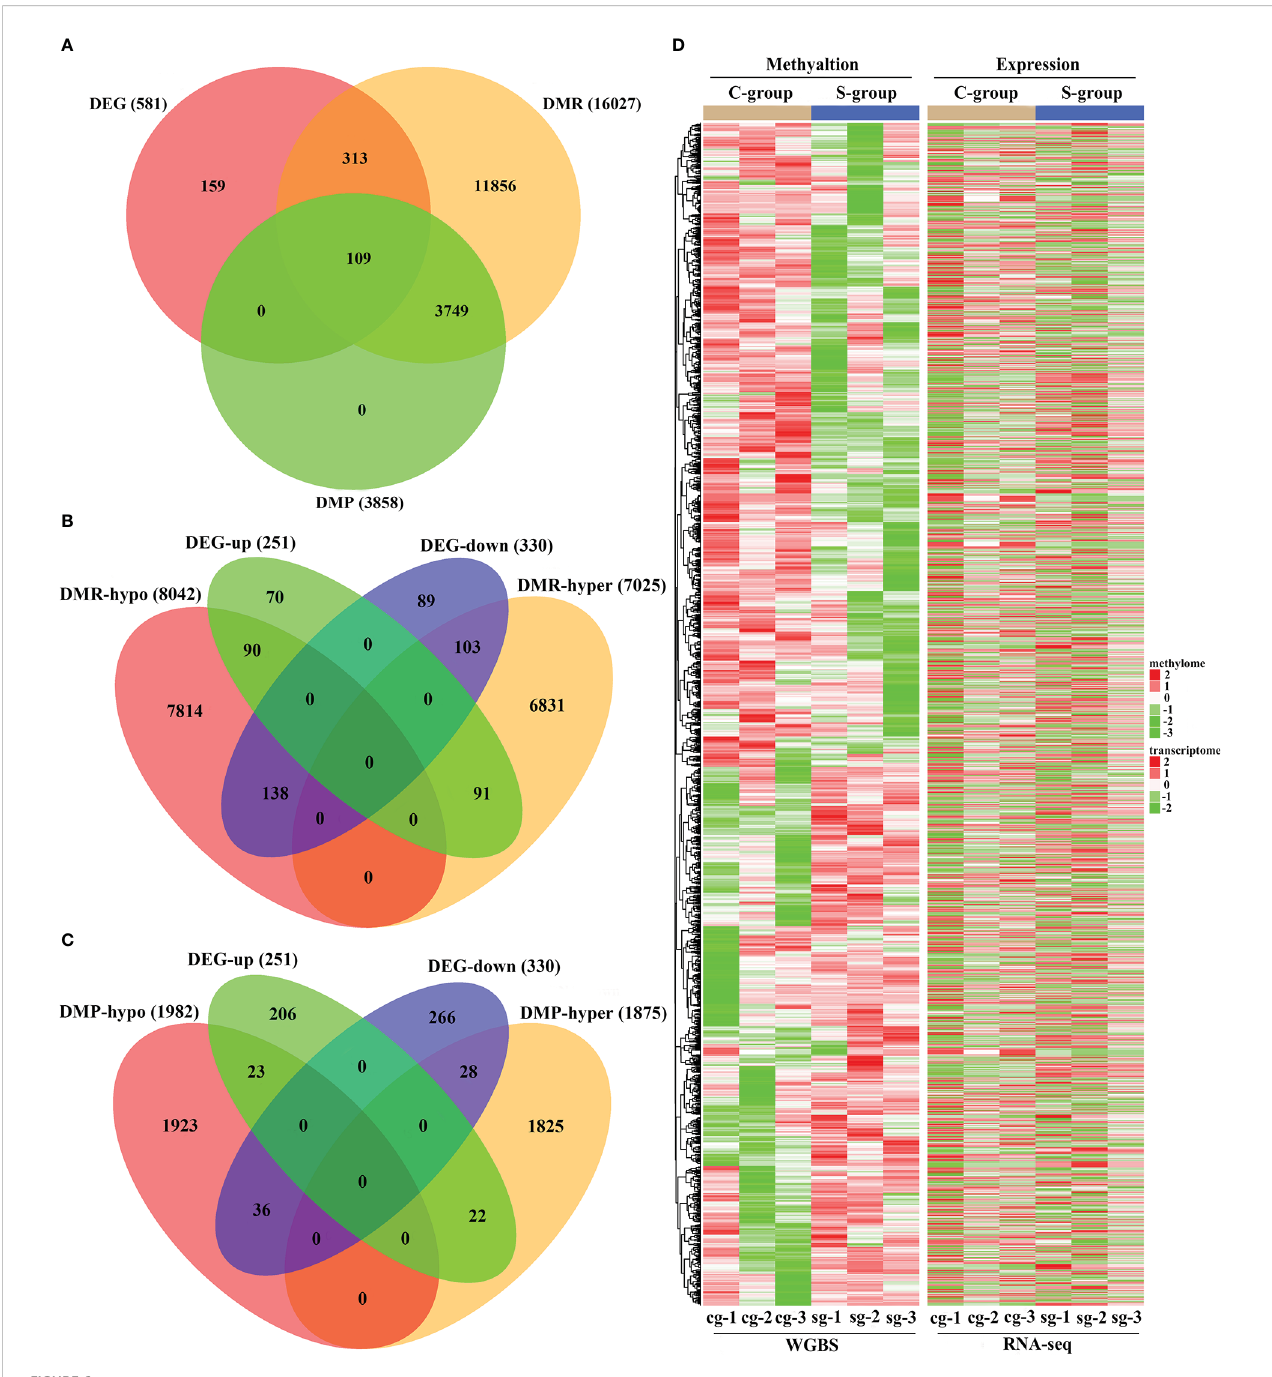
FIGURE 6 Integrative analysis of RNA-seq and WGBS data of gill tissue of large yellow croaker under low-salinity stress. (A) Venn diagram of overlapped genes of DMGs and DEGs in gill tissue of large yellow croaker between the S-group and C-group; (B) Venn diagram of overlapped genes of DEG expression and DMR target DMGs in gills between the S-group and C-group; (C) Venn diagram of overlapped genes of DEG expression and DMP target DMGs in gills between the S-group and C-group; (D) Heatmap showing the patterns between the DEG expression and methylation of the DMR target DMGs in the gills of large yellow croaker under low-salinity